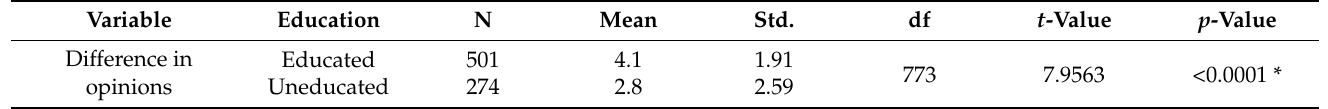
Table 3. Difference in motivational factors influence for purchasing luxury brands (By